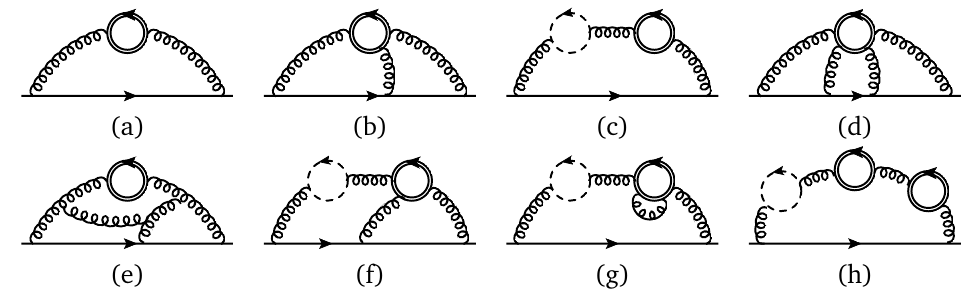
Figure 1: Sample Feynman diagrams contributing to relation between the MS and on-shell mass. Straight and curly lines represent quarks and gluons, respectively. Dashed and double lines represent massless fermions and fermions with mass m respectively.